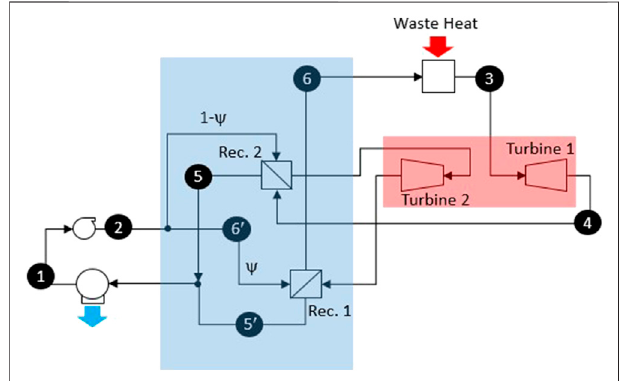
FIGURE 11 | Supercritical CO 2 Rankine cycle with split- fl ow and cascaded turbine.